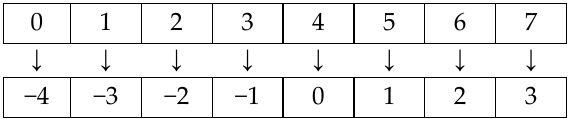
Figure 2. The example of k = 3.